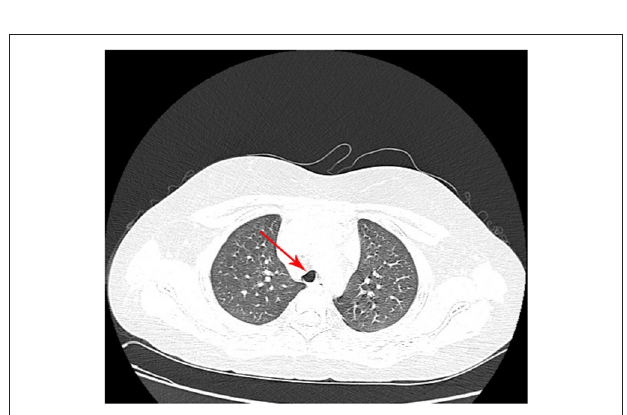
FIGURE 4 | Chest computed tomography at 1 year postoperatively shows that the anterior wall of the trachea has collapsed